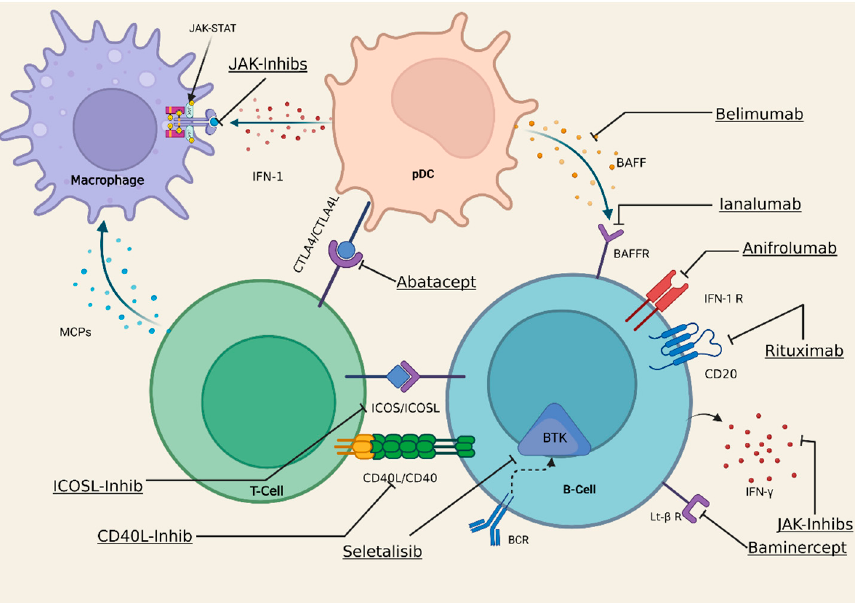
Figure 2. Sjögren’s syndrome targets and future treatments. This figure illustrates some current or potential therapeutic target in relation to immune cells involved in SS pathogenesis. IFN-1, Interferon-1; IFN-1 R, Interferon-1 Receptor; IFN- γ , Interferon- γ ; pDC, plasmacytoid dendritic cell; BTK, Bruton-Kinase; JAK, Janus-Kinase; BAFF, B cell activating factor belonging to TNF family; BCR, B-cell receptor; Lt- β R, Lymphotoxin-beta-receptor; CD40L, CD40 Ligand; ICOSL, Inducible co-stimulator ligand; CTLA4L, Cytotoxic T-Lymphocyte antigen 4 ligand. Created with www.BioRender.com, accessed on 13 October 2022.